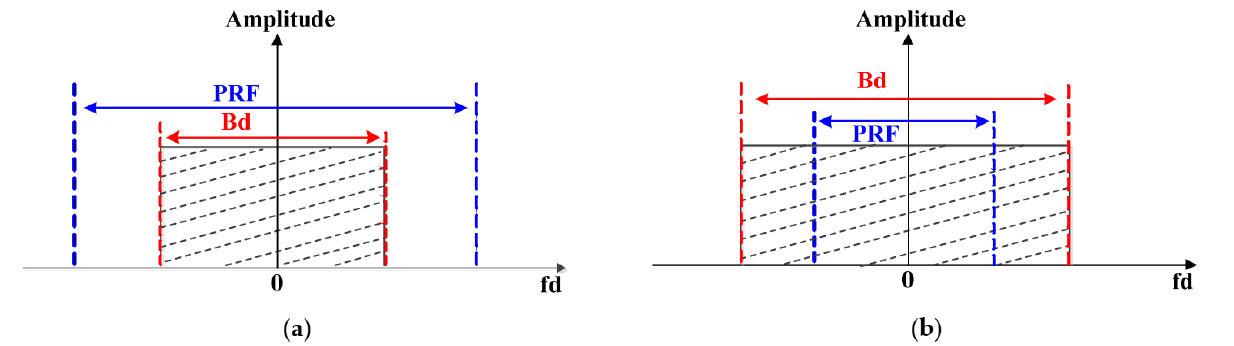
Figure 2. The relation between the extended Doppler bandwidth and the given PRF. ( a ) The limited target detectable interval as a result of the Doppler bandwidth expansion; ( b ) The Doppler ambiguity issue caused by the extended Doppler